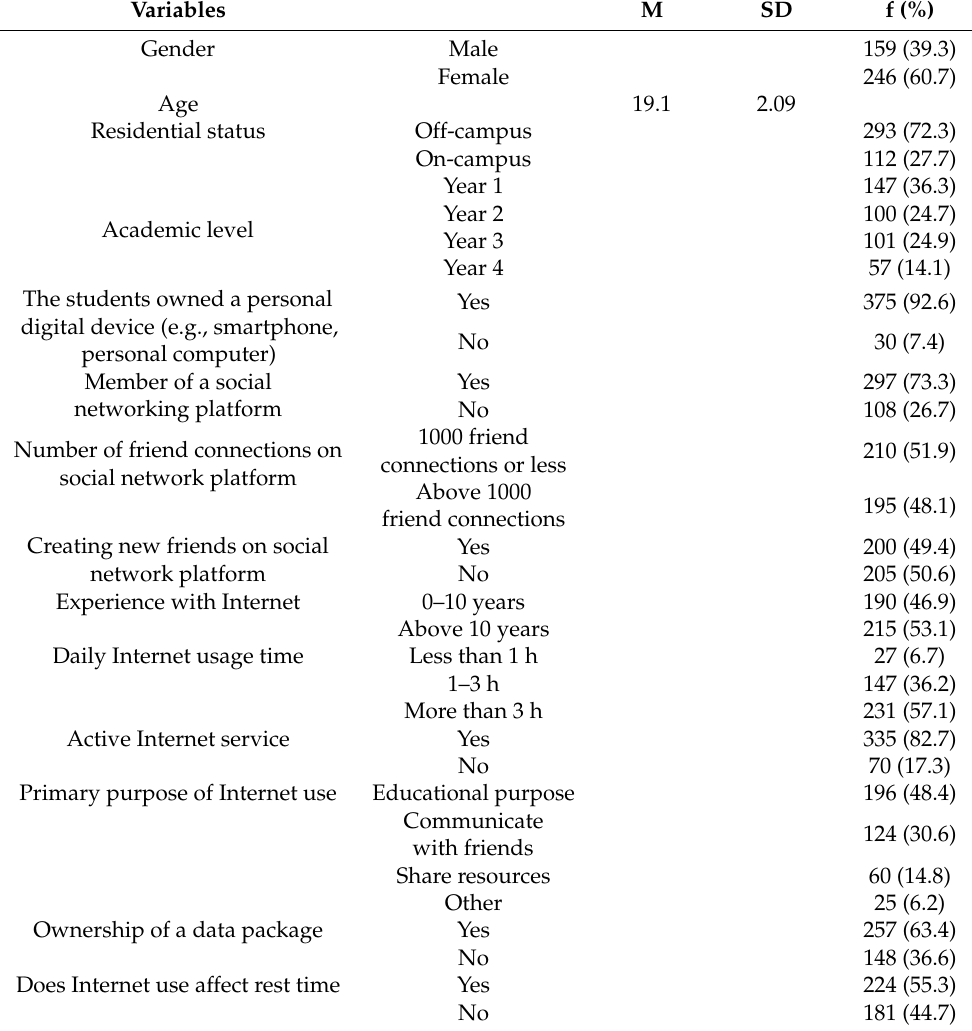
Table 1. Characteristics of the